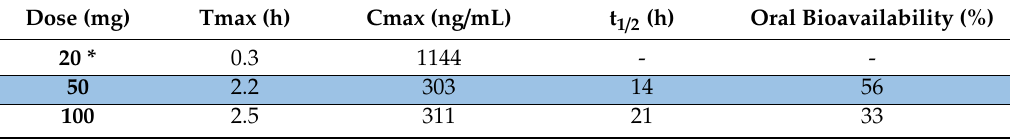
Table 4. Pharmacokinetic data for 76 from phase 0 clinical studies.